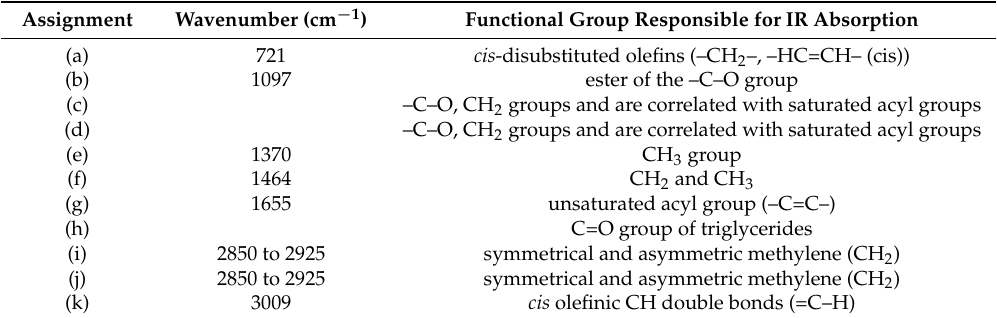
Table 3. Assignment of functional groups present in Salmo salar and Onconrhynchus mykiss fat responsible for infrared absorption.